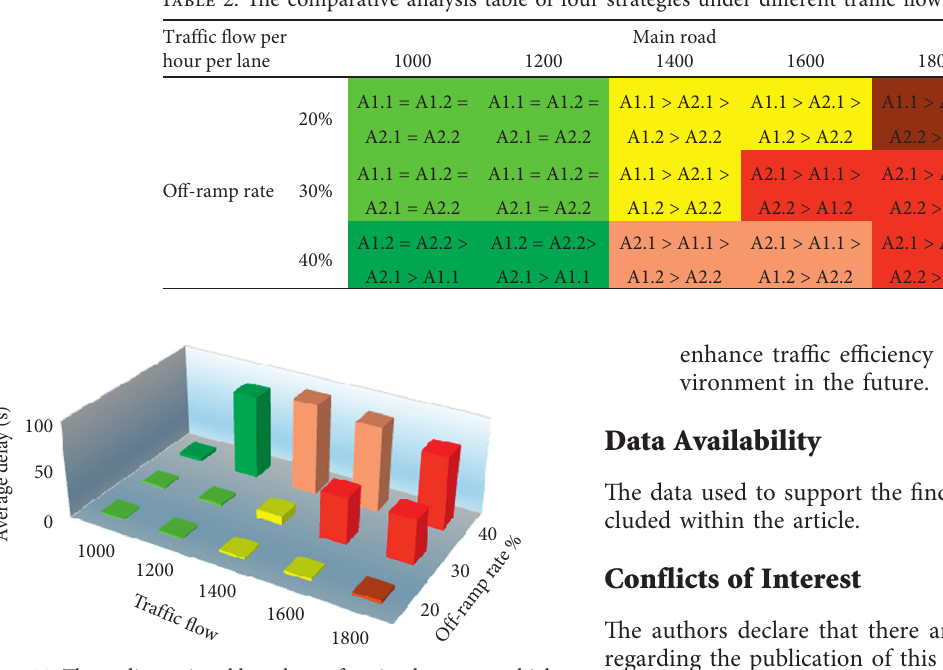
Figure 13: Three-dimensional bar chart of optimal average vehicle delays for different traffic flow